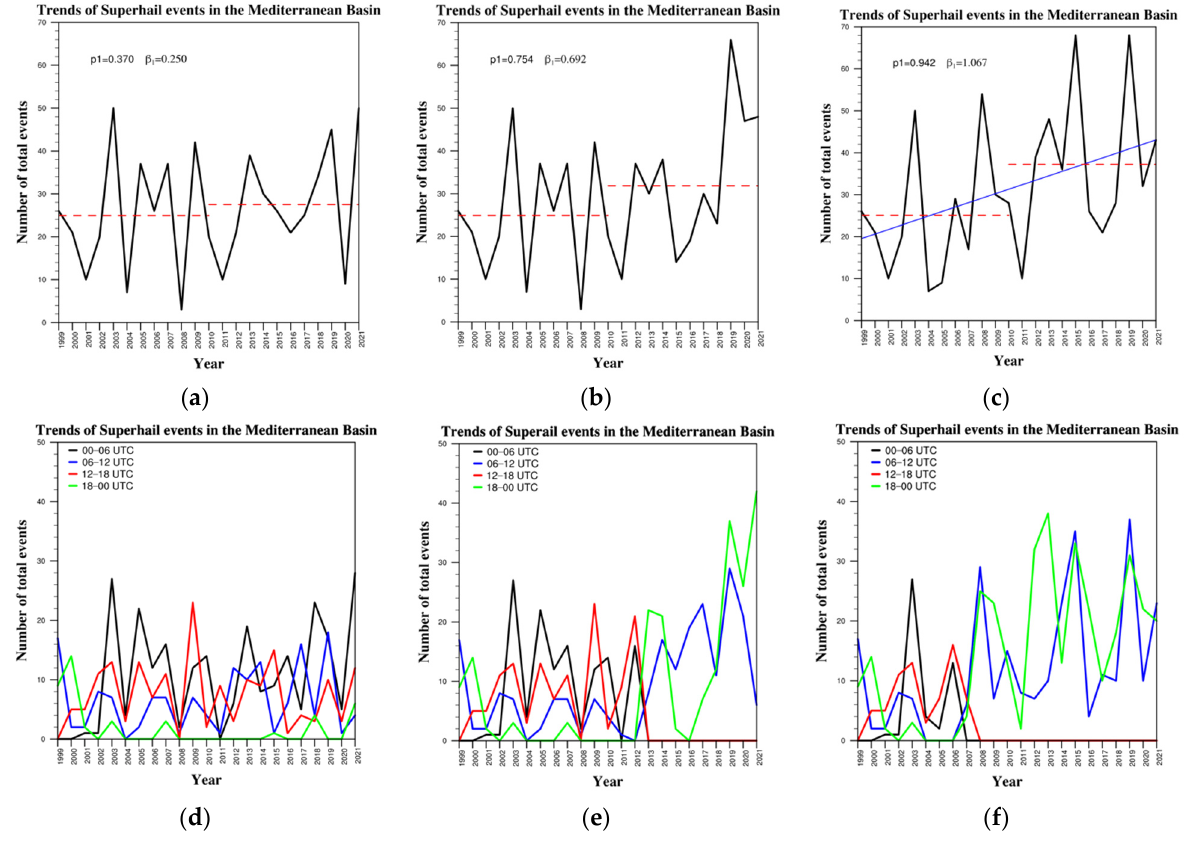
Figure 9. ( a–f ) Same as in Figure 7 but for SH events. Figure 9. ( a – f ) Same as in Figure 7 but for SH events.